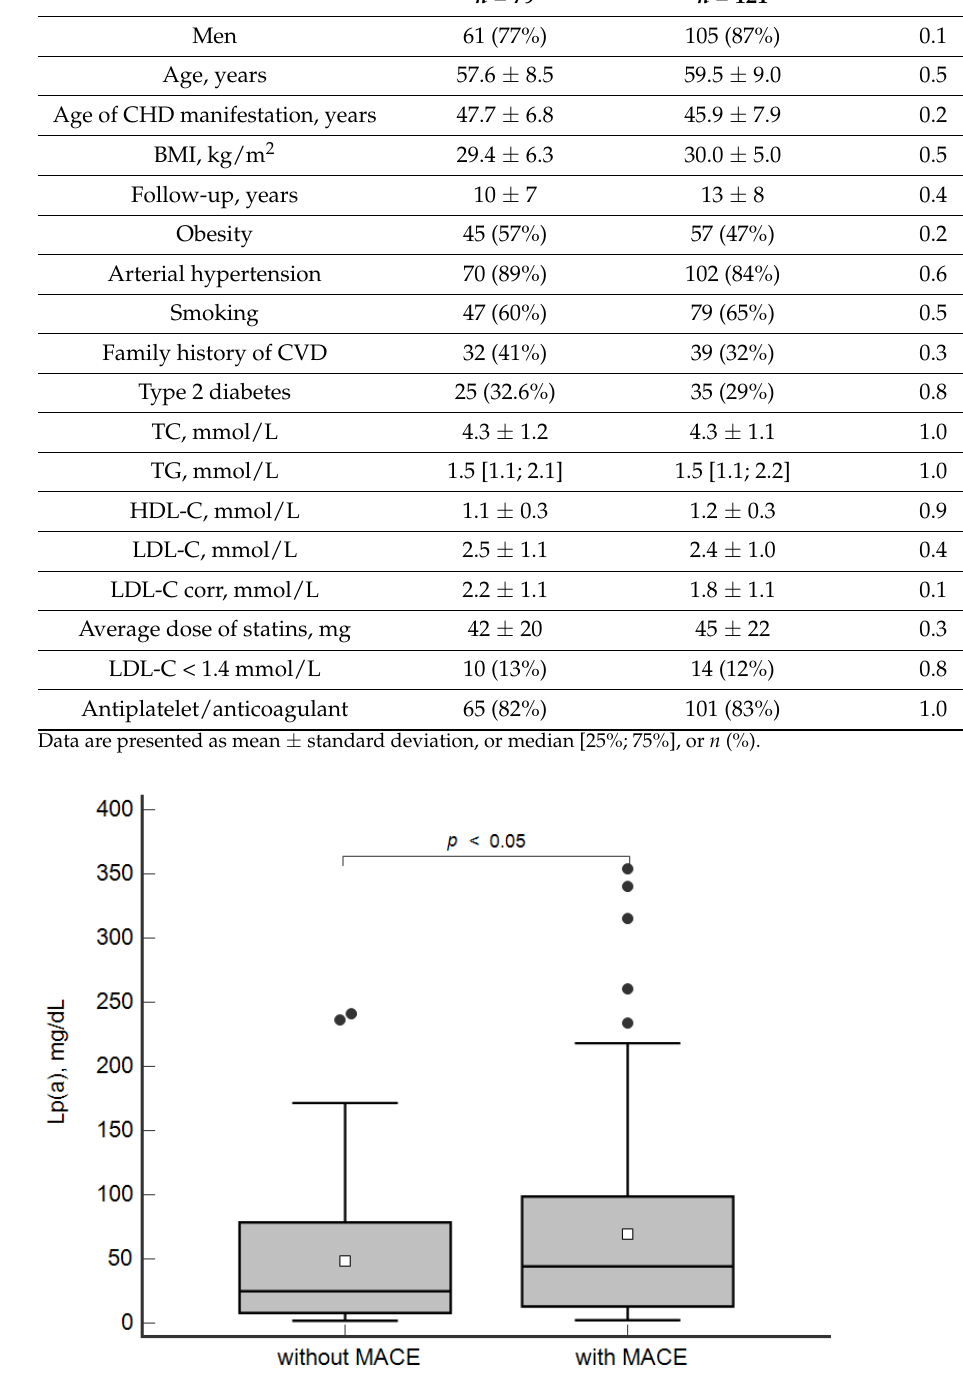
Figure 1. Concentration of lipoprotein(a) in patients with and without MACE. Data are presented as Box-and-Whisker plot: a grey box is drawn from the 25% and 75%; a horizontal line is a median (50%), a white square symbol is a mean, black points are values to the above of 1.5 × IQR (the Interquartile range (IQR) is calculated as 75% − 25%).